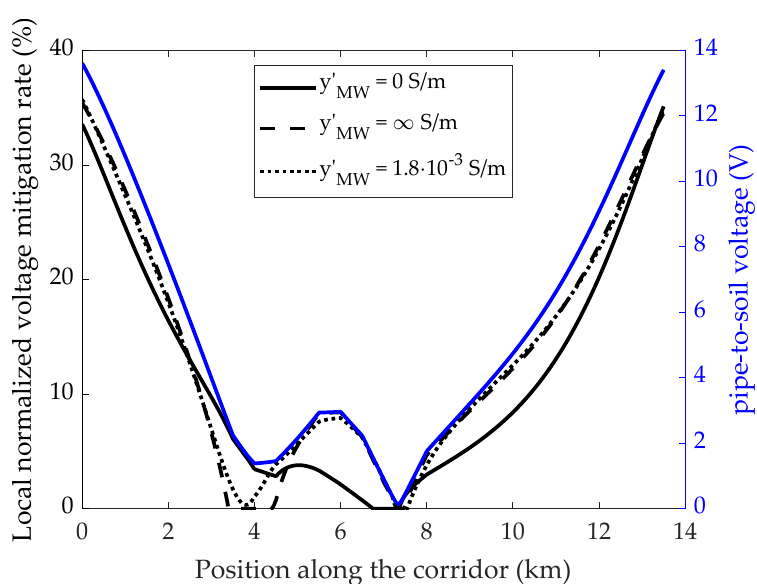
Figure 9. Normalized local mitigation rate along the corridor for three different values of p.u.l admittance to earth of the four (cylindrical) mitigation wires (left axis); unmitigated pipe-to-soil voltage (right axis).